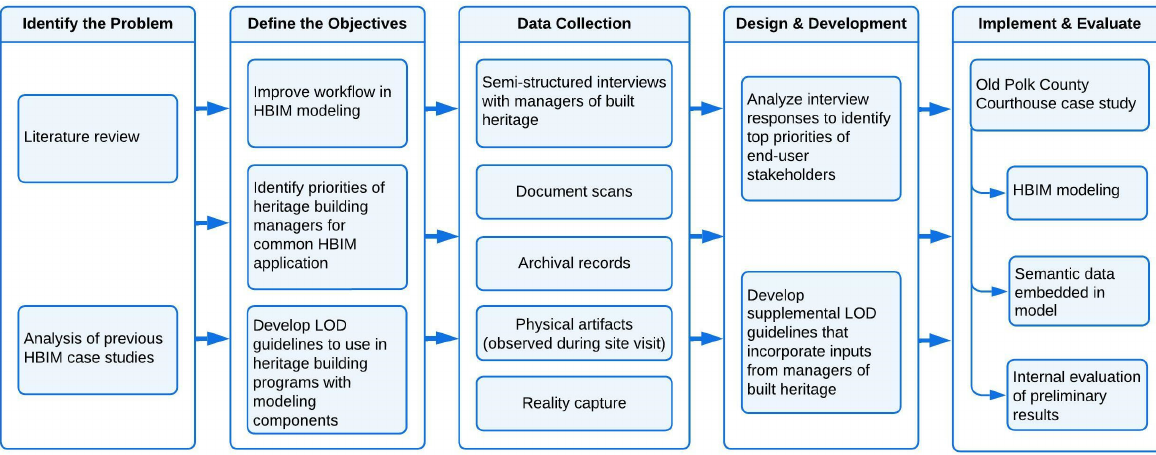
Figure 8. Research methodology and design.